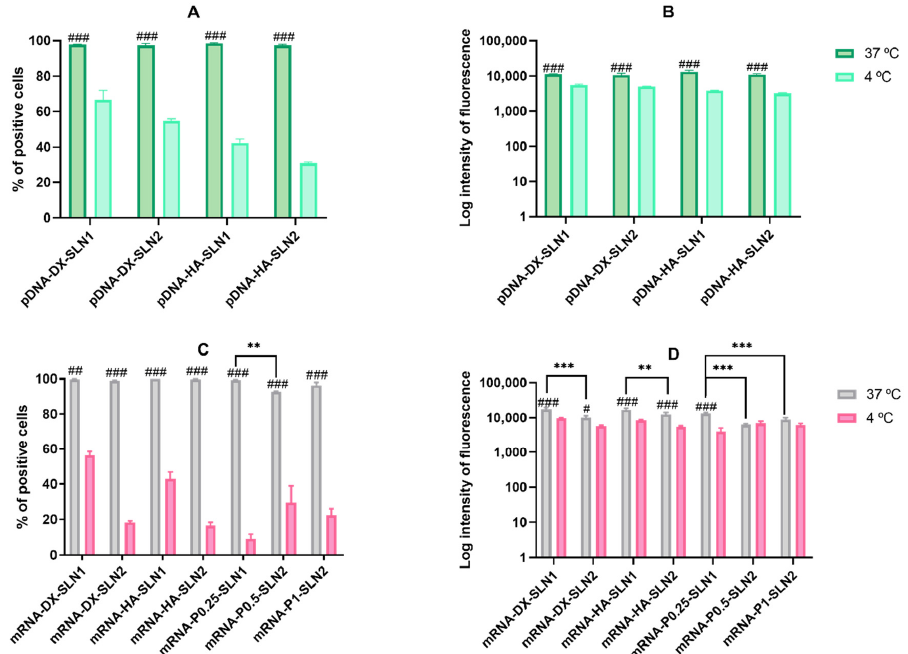
Figure 6. Flow cytometry analysis of cellular uptake of vectors, using Nile Red–labeled pDNA- and mRNA-SLNs in HEK-293 cells, at 37 and 4 ◦ C. Data are expressed as mean ± standard deviation; n = 3 ( A ) Percentage of Nile Red positive HEK-293 cells 2 h after the treatment with pDNA vectors. ( B ) Intensity of fluorescence of Nile Red positive HEK-293 cells 2 h after the treatment with pDNA vectors. ( C ) Percentage of Nile Red positive HEK-293 cells2 h after the treatment with mRNA vectors. ( D ) Intensity of fluorescence of Nile Red positive HEK-293 cells 2 h after the treatment with mRNA vectors. # p < 0.05 with respect to the same vector at 4 ◦ C. ## p < 0.01 with respect to the same vector at 4 ◦ C. ### p < 0.001 with respect to the same vector at 4 ◦ C. ** p < 0.01 with respect to the other formulation. *** p < 0.001 with respect to the other formulation.